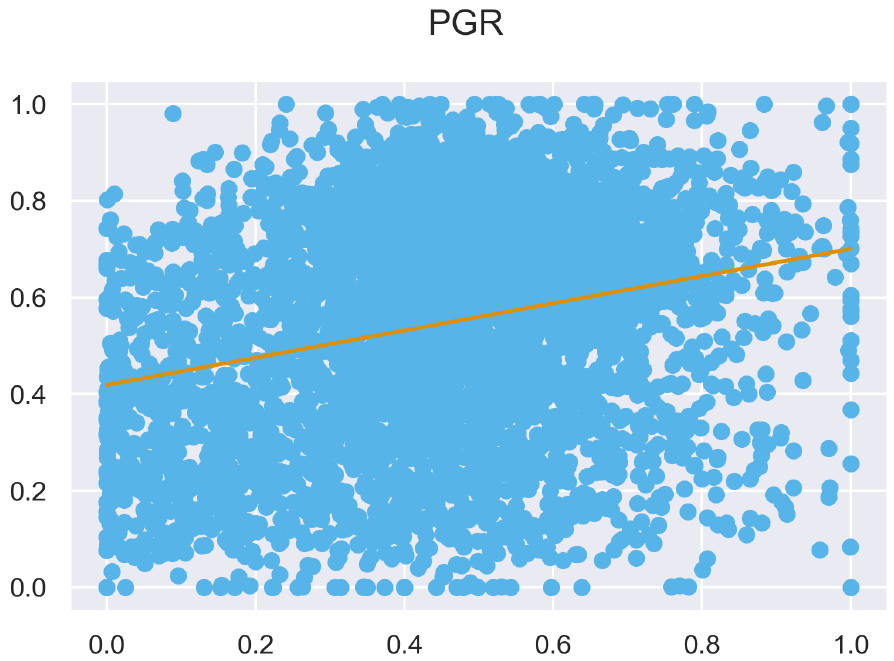
Figure A31. ULS and TLS PGR regression at 1m grid